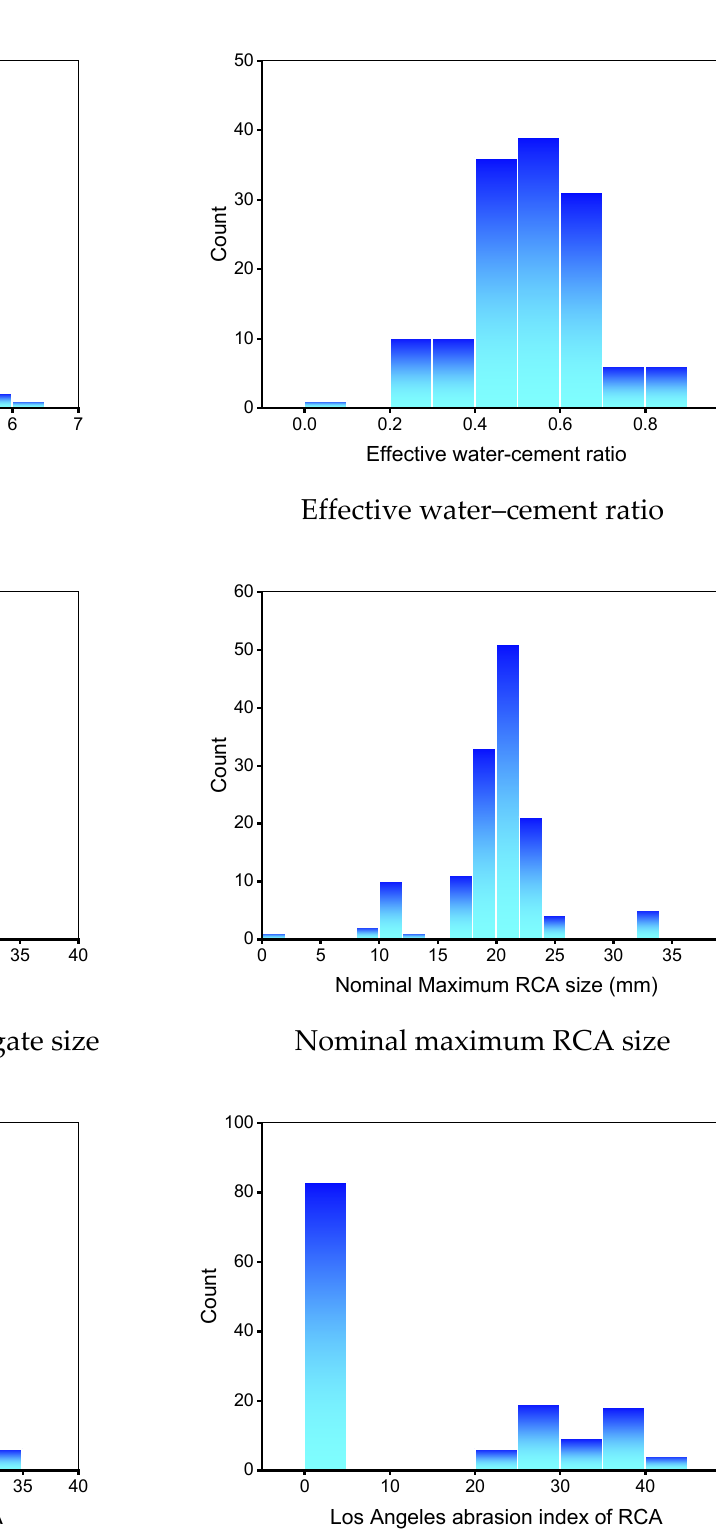
Figure 2. Relative frequency dispersal of inputs parameters for the flexural strength dataset. NA: natural aggregate, RCA: recycled concrete aggregate.